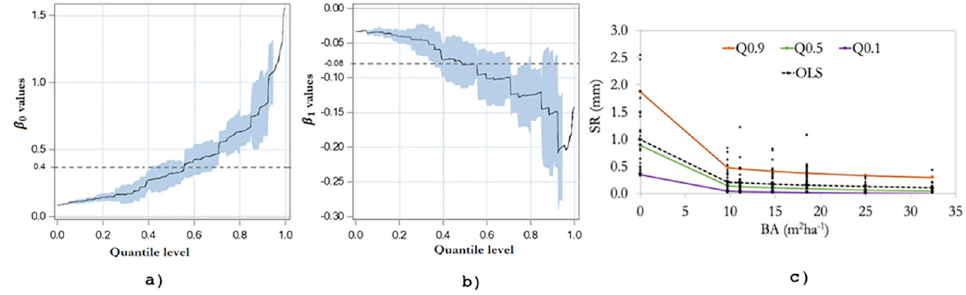
Fig 5. Quantile regression coefficients for the parameters used to estimate surface runoff ( n = 249). Fig a) shows the intercept estimates and 95% confidence limits, b) shows the slope estimates and 95% confidence limits, and c) represents the regression lines for quantiles 0.9, 0.5, and 0.1. The dashed line in each figure stands for the ordinary least squares estimate of the conditional mean